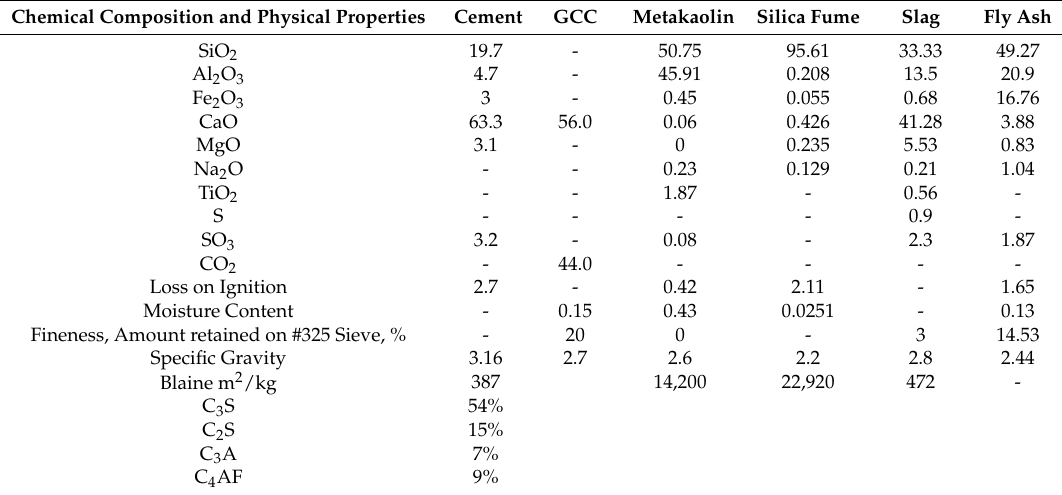
Table 2. Chemical Composition and Physical Properties of the